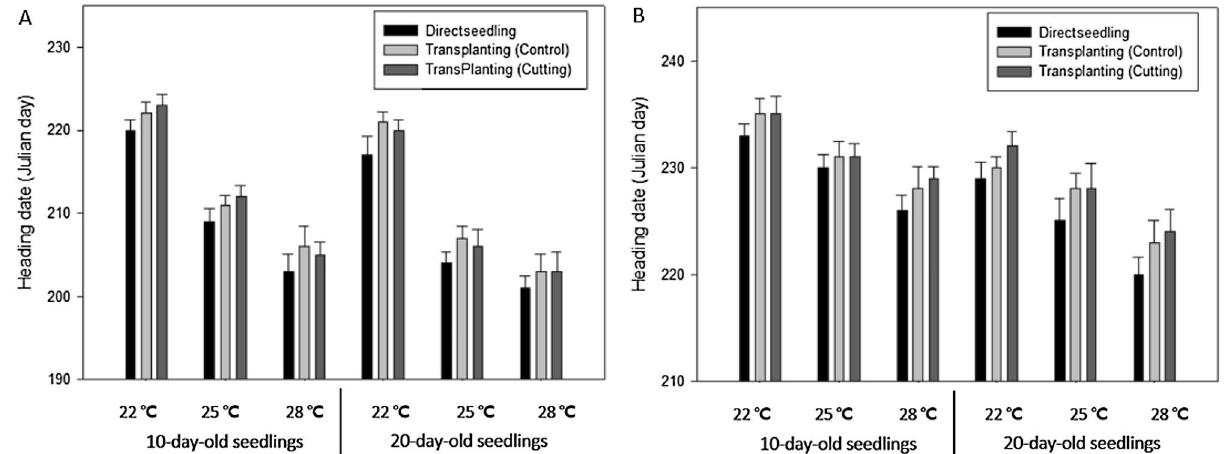
Figure 2. Differences in the time to heading of two rice cultivars in relation to root damage during transplantation, seedling age, and growth temperature. ( A ) Odae and ( B ) Saenuri. Error bars show standard deviations.